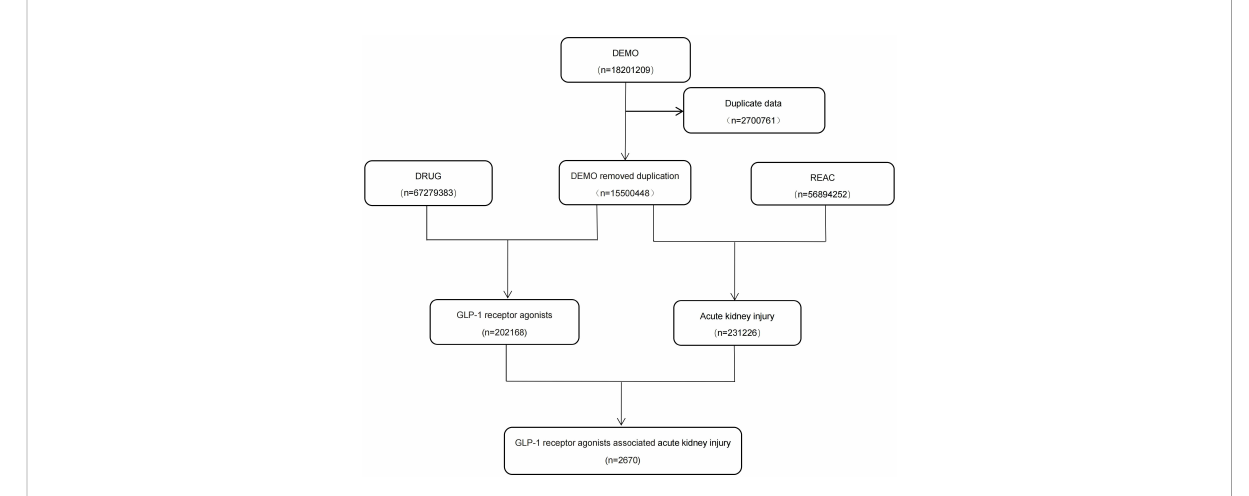
FIGURE 1 Process of screening cases of acute kidney injury caused by GLP-1 receptor agonists from FAERS database. FAERS, FDA Adverse Event Reporting System; GLP,glucagon-like